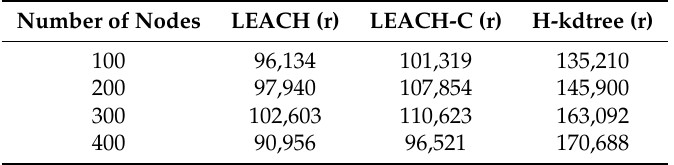
Table 15. Throughput (bps). (r) random.